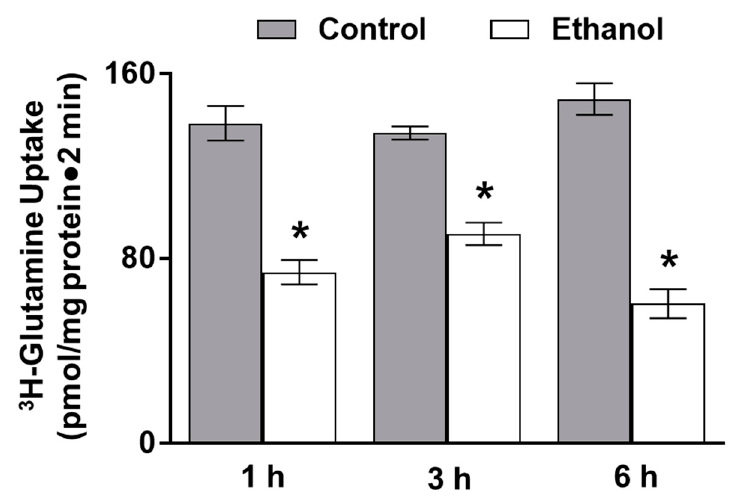
Figure 1. Moderate ethanol significantly inhibited glutamine absorption in SD rats. Sodium-dependent glutamine activity was determined using 3 H-glutamine uptakes with and without a sodium-free condition in control and ethanol-treated rats (* p < 0.01, n = 4). The error bars represent the SEM. P-values were adjusted for multiple hypotheses using a Bonferroni correction (1 h: p < 0.01; 3 h: p < 0.01; 6 h: p < 0.01).